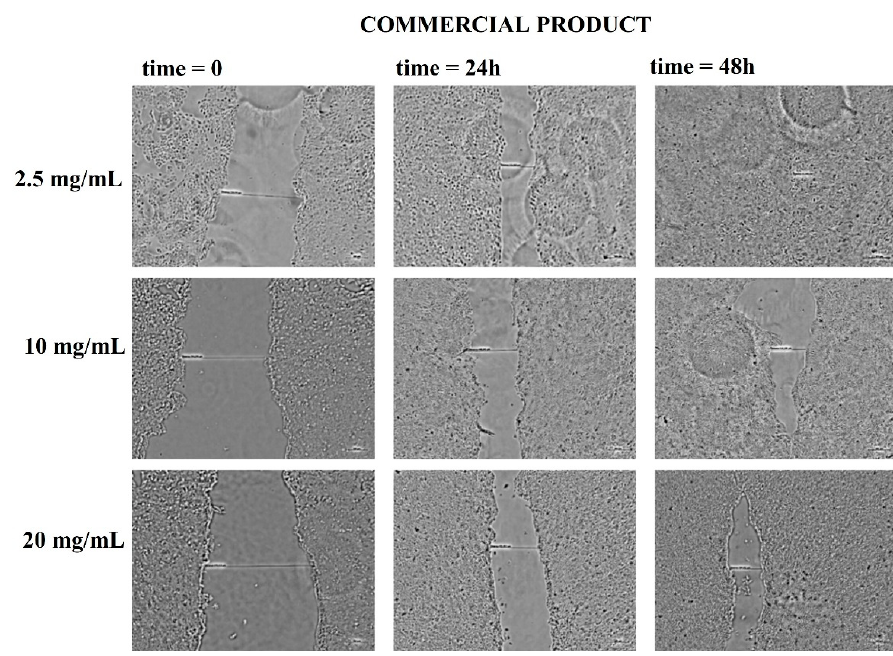
Figure 8. Wound healing assay: samples photomicrographs.